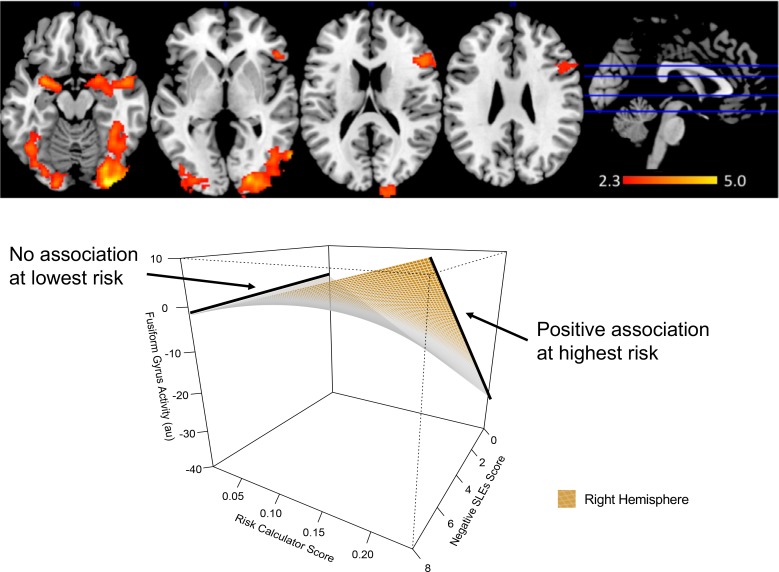
Interaction effects of risk calculator score and negative stressful life events schedule (nSLES) score on whole-brain activity during emotion processing (top).Positive interactions between risk calculator score, nSLES score and activity were found within 3 clusters after correction for multiple comparisons. A graphical representation of this interaction in the right fusiform gyri is presented here (bottom). Higher risk calculator score showed a greater positive association between activity and nSLES score. A full set of these interaction plots can be found in the supplementary. * au = arbitrary units All results were corrected for using Z-statistic threshold at z>2.3, pFWE<0.0017. A contrast of all emotions versus shape conditions was used. Activity values were mean adjusted using a healthy control sample.